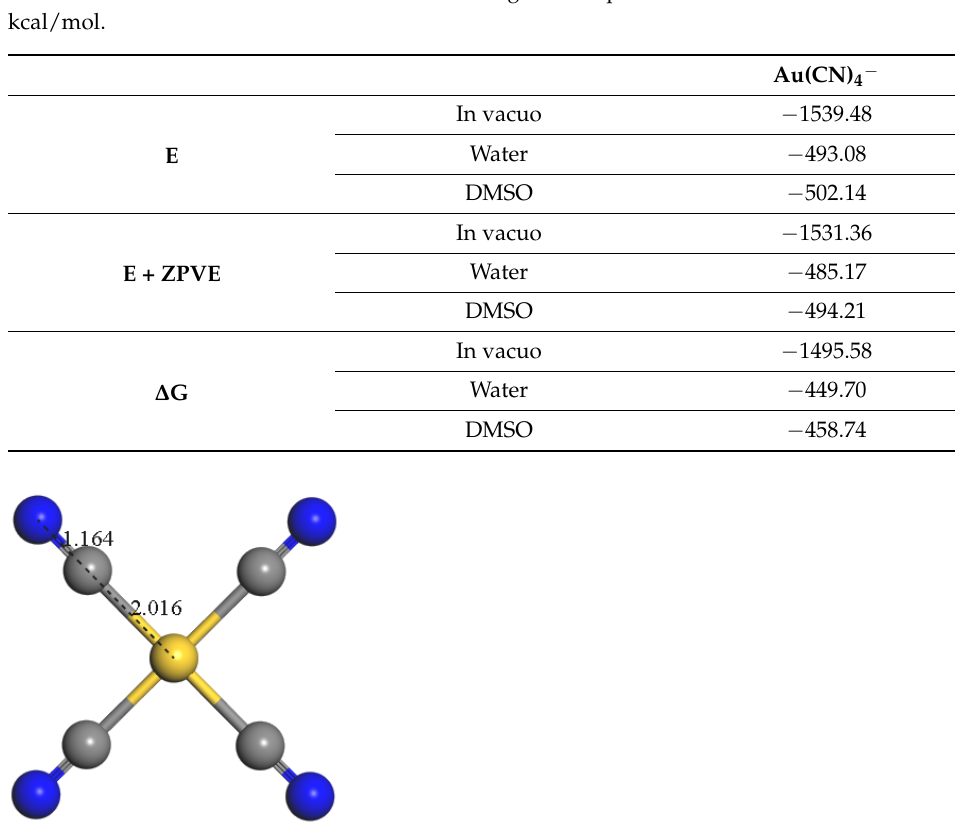
Figure 2. The structure of the most stable gold(III) tetracyanide isomer, Au(CN)4 − . The values indicate the N-C (1.164 Å) and C-Au (2.106 Å) lengths. Atom coloring: Au—gold, C—grey, N—blue.